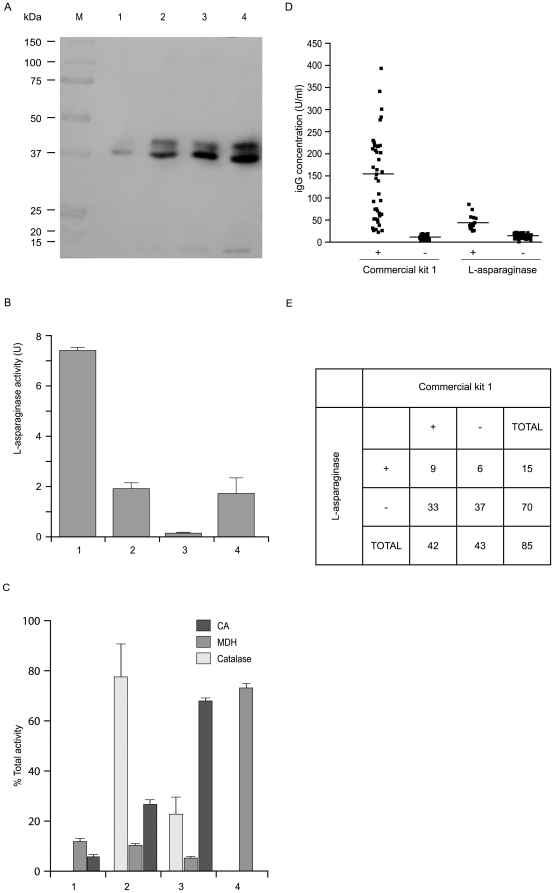
Subcellular localisation of L-asparaginase and ELISA assays.(A) Western blot performed on 100 µg of the subcellular fractions of H. pylori CCUG 17874 with an anti-asparaginase antibody. From left to right: 1: pre-lytic fraction; 2: periplasmic fraction; 3 and 4: soluble and insoluble spheroplast fractions, respectively. Molecular mass markers (kDa) are indicated. (B) Total L-asparaginase activity associated with each fraction (U). (C) Catalase, carbonic anhydrase (CA) and malonate dehydrogenase (MDH) were found in the expected H. pylori subcellular fractions: periplasm (2)[34], spheroplast (3) [35] and cytoplasm (4) [36], respectively. (D) Scatter-plot of ELISA assay results on sera from 42 H. pylori positive and 43 H. pylori negative patients. Serum samples (1∶101 dilution) were tested in parallel using commercial kit 1 and plates pre-coated with recombinant H. pylori L-asparaginase. Medians indicated as horizontal bars. 21% of the total samples were anti-L-asparaginase IgG positive (+). (E) Comparison of the results obtained with commercial kit 1 and L-asparaginase-based ELISA.